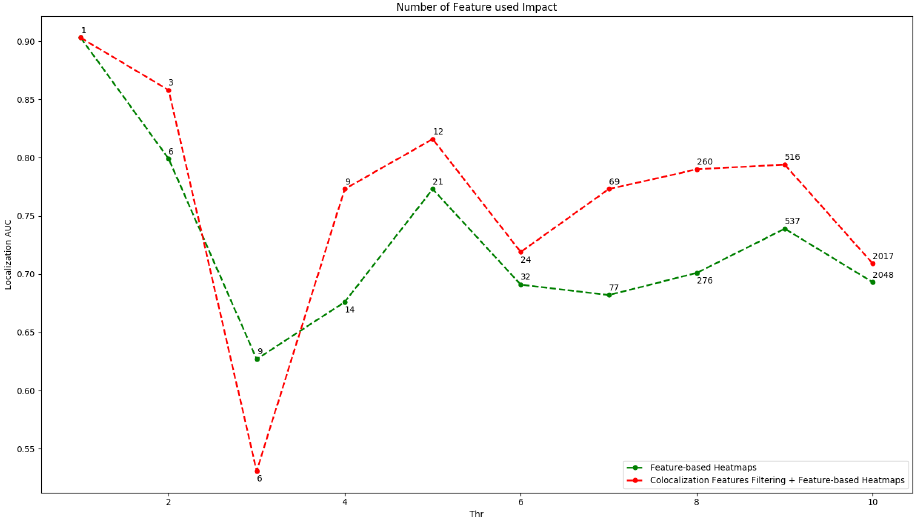
Figure 14. Colocalization filtering results for the attention-based